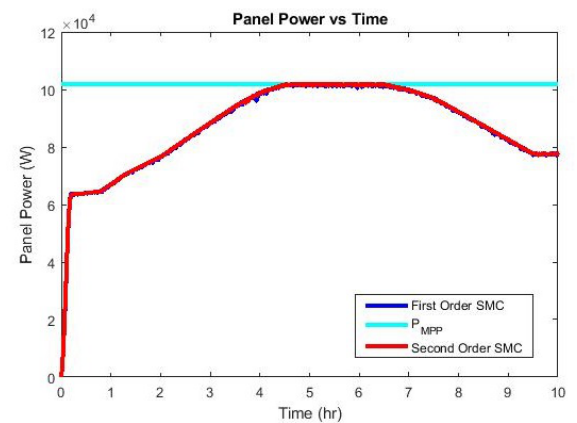
Figure 17. PV array output power under changing irradiation.